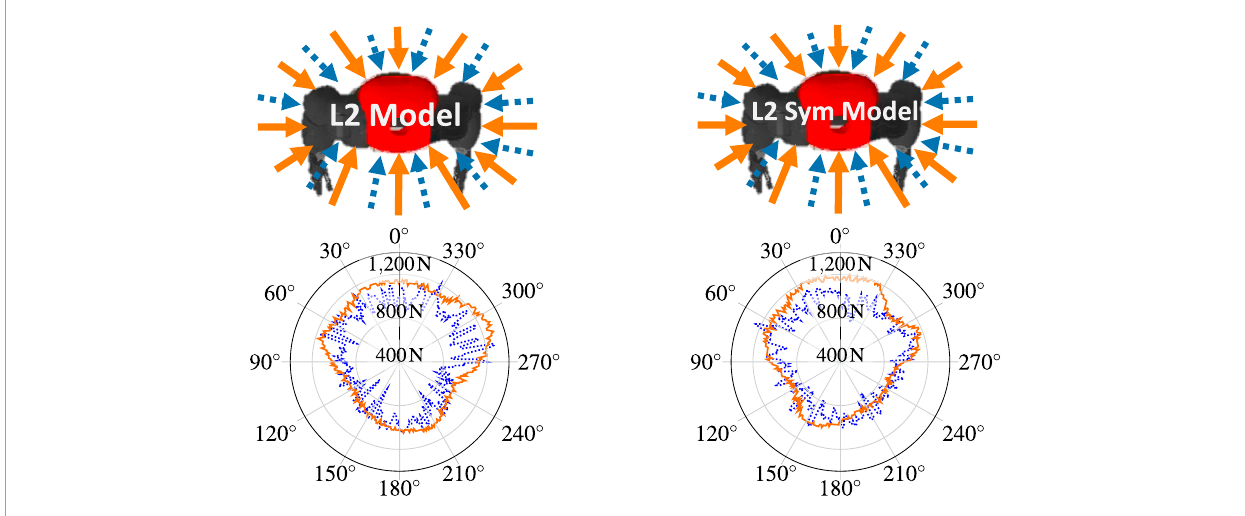
FIGURE 7 Maximum radially applied external force from which the robot can consistently recover as a function of the direction of application, where zero degrees corresponds to the front of the robot. On the left is shown the policy which learned on L2 and on the right L2 Sym . The force was applied both in the flat terrain (solid orange line) and the uneven terrain (dotted blue line). The radial y-axis range is [400,1400]N. The maximum withstood force was 1300 N for the L2 policy in the flat terrain, at 290°.